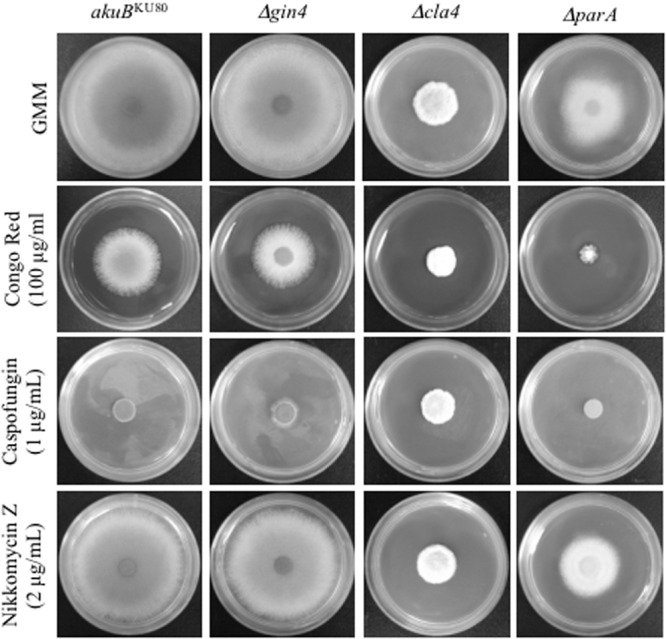
Deletion of parA increased susceptibility to Congo Red, but not to anti-cell wall drugs. Conidia (104) from each strain were inoculated into GMM agar, GMM agar containing Congo Red (100 μg), Caspofungin (1 μg/ml), or Nikkomycin Z (2 μg/ml), and incubated for 3 days at 37°C.